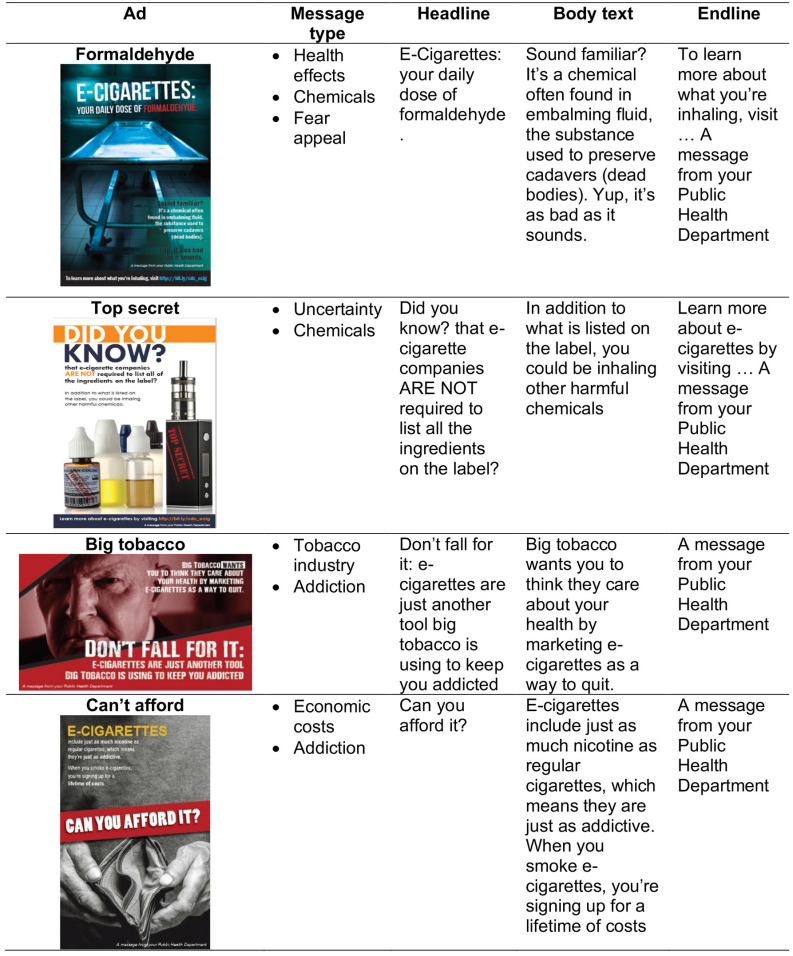
Description of e-cigarette messages used in the study.